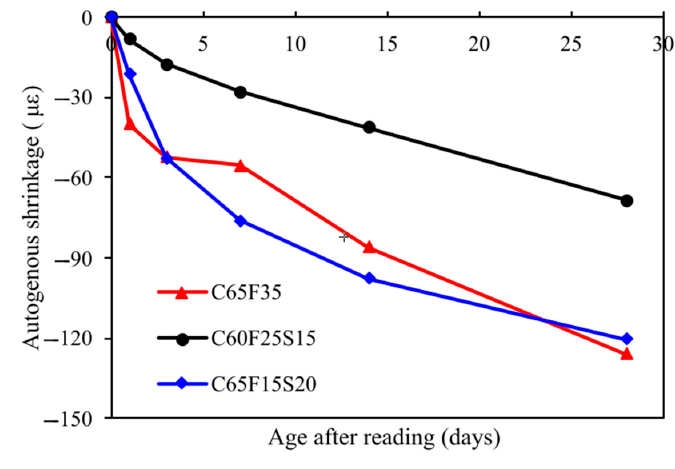
Figure 7. Autogenous shrinkage of concrete.